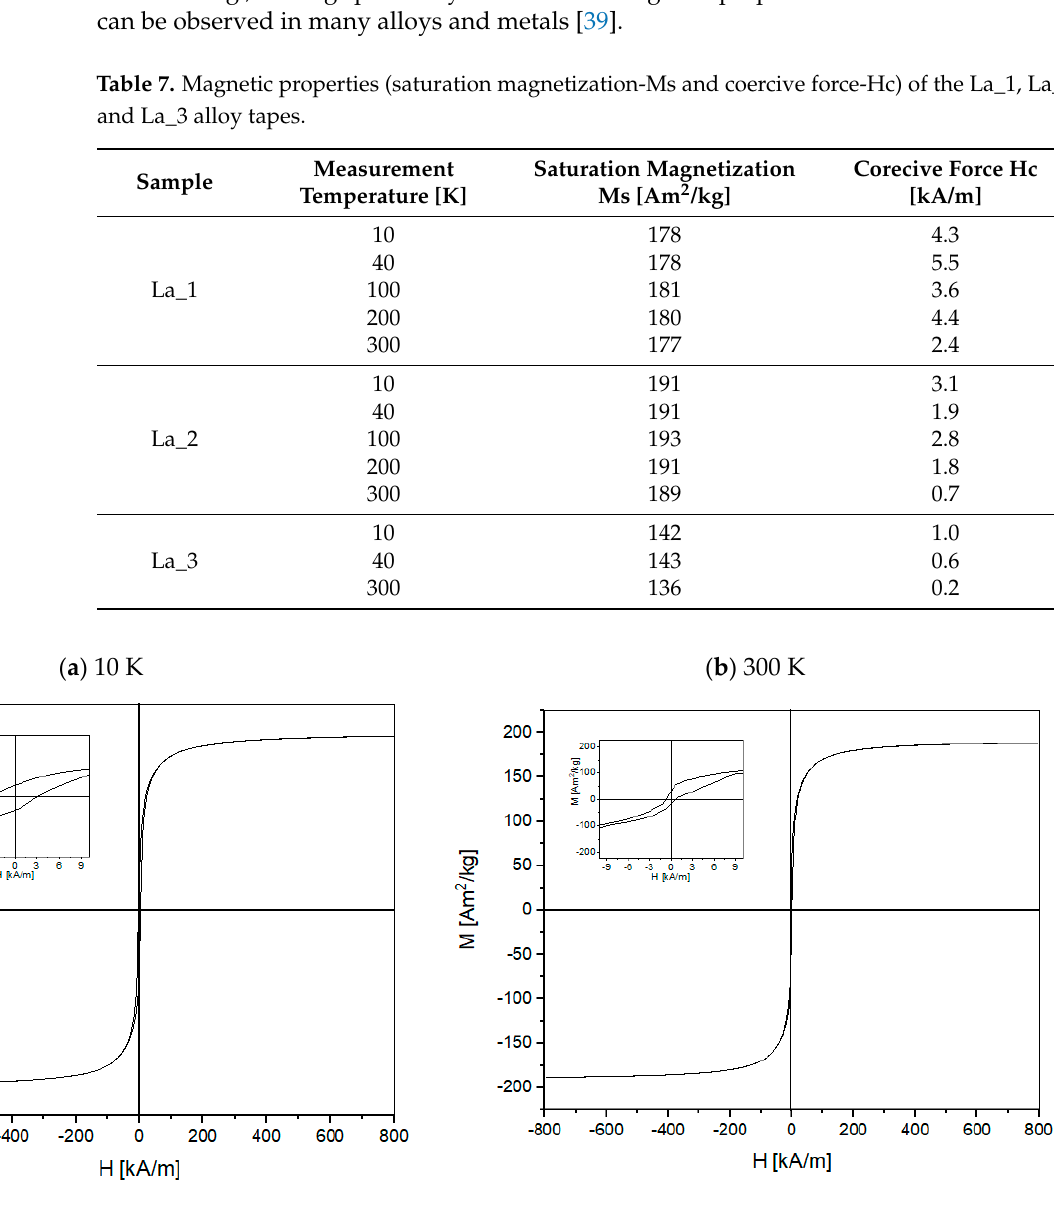
Figure 5. The hysteresis loops of La_2 alloy tape measured at various temperatures: ( a ) 10 K, ( b ) 300 K.